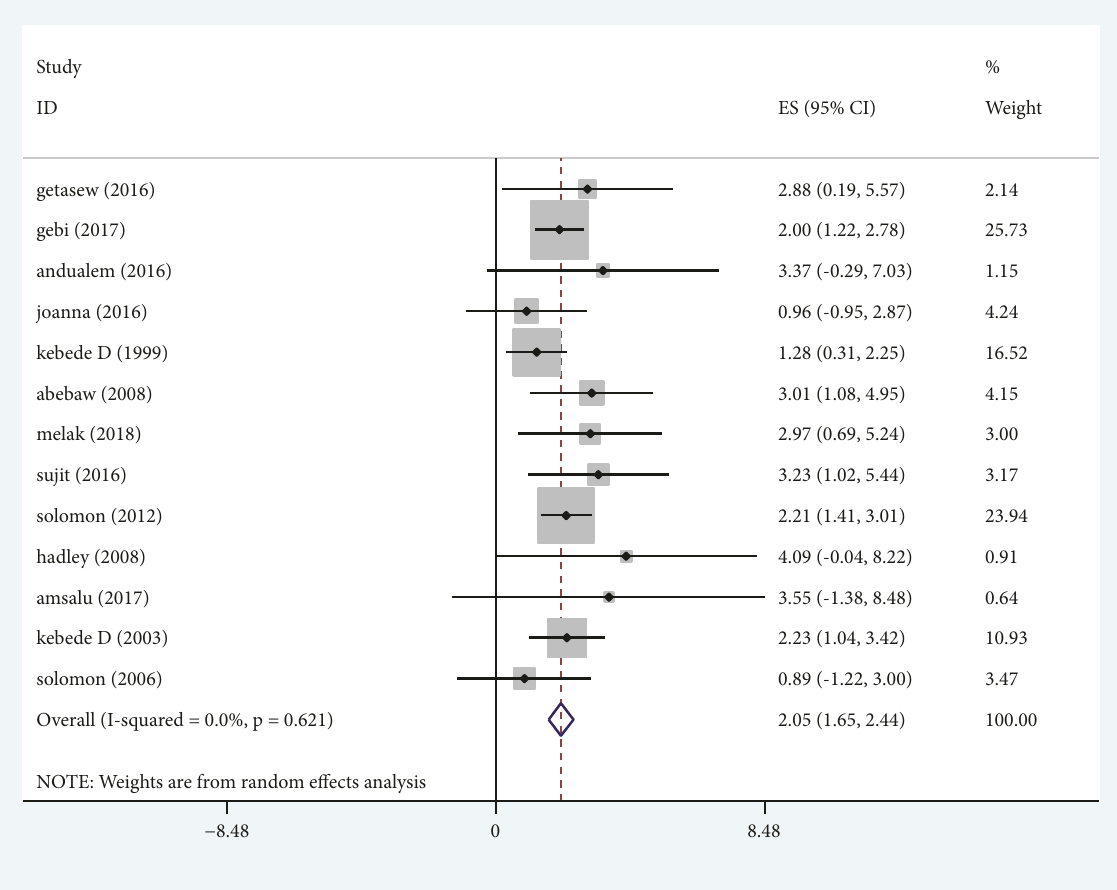
Figure 2: Forest plot presenting the pooled prevalence of depression using random effect models with 95%